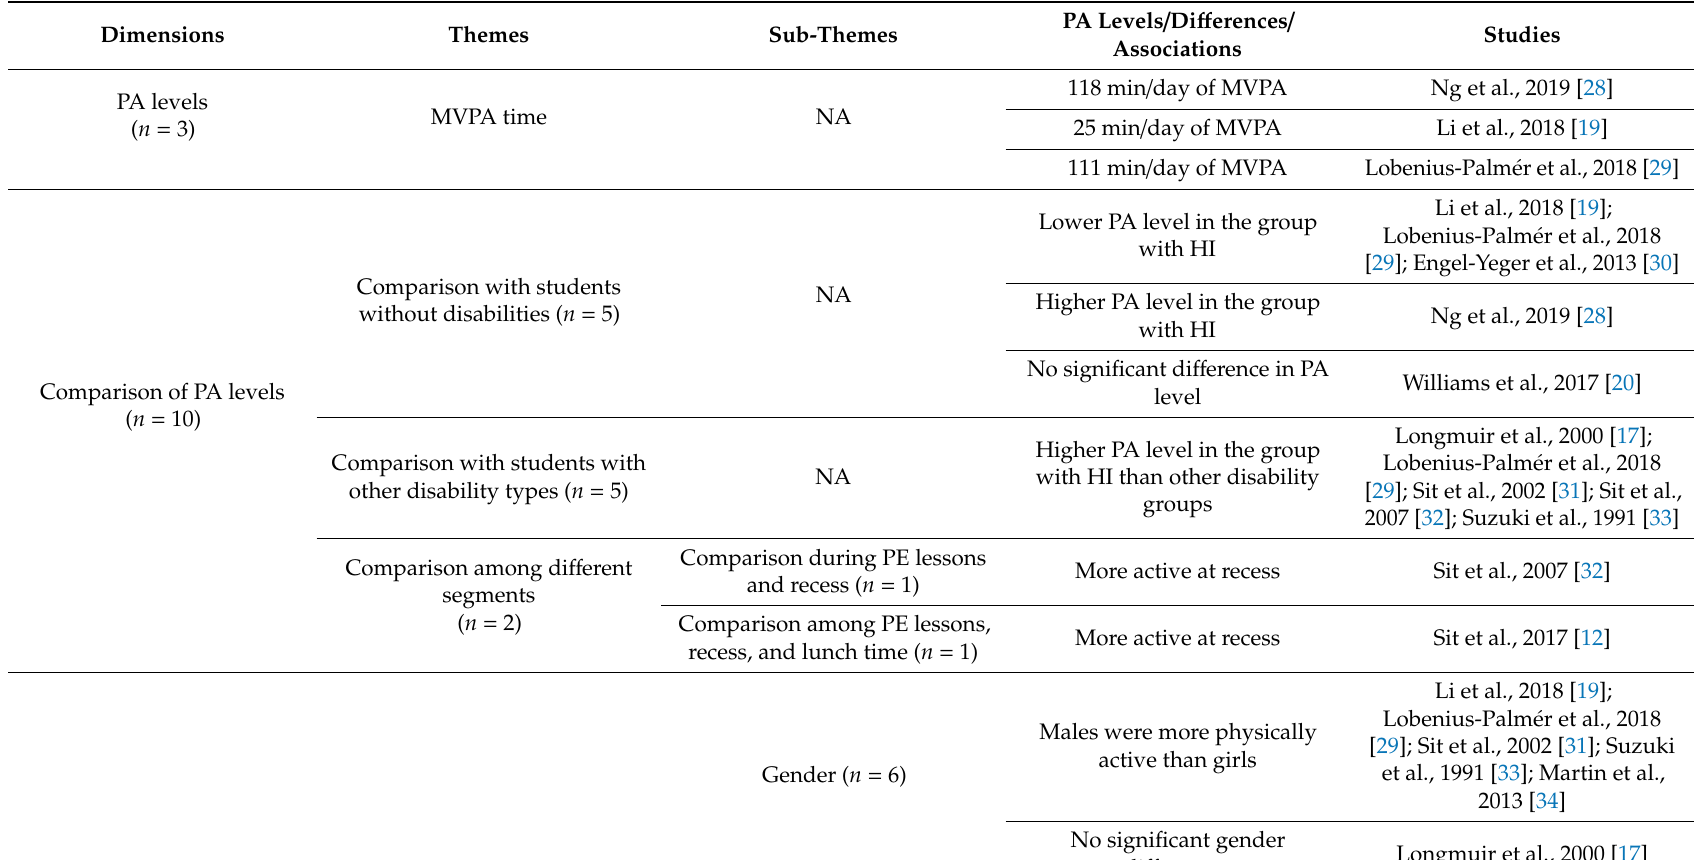
Table 3. Summary of the key themes and